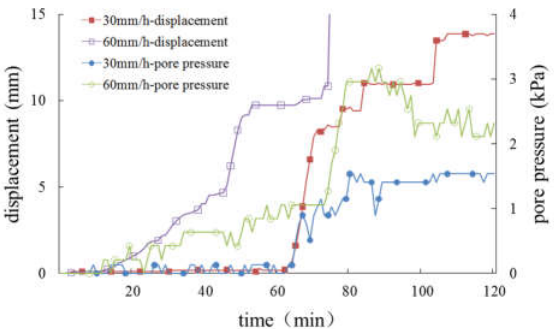
Figure 19. Curves of displacement and pore pressure in the slope with a weak layer of 20 cm.